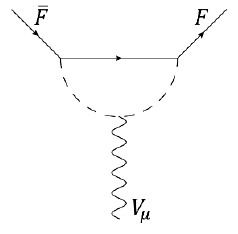
Figure 5 . Vertex diagram contributing to KK-number violating vector-boson-fermion couplings involving a KK-Higgs in the loop.